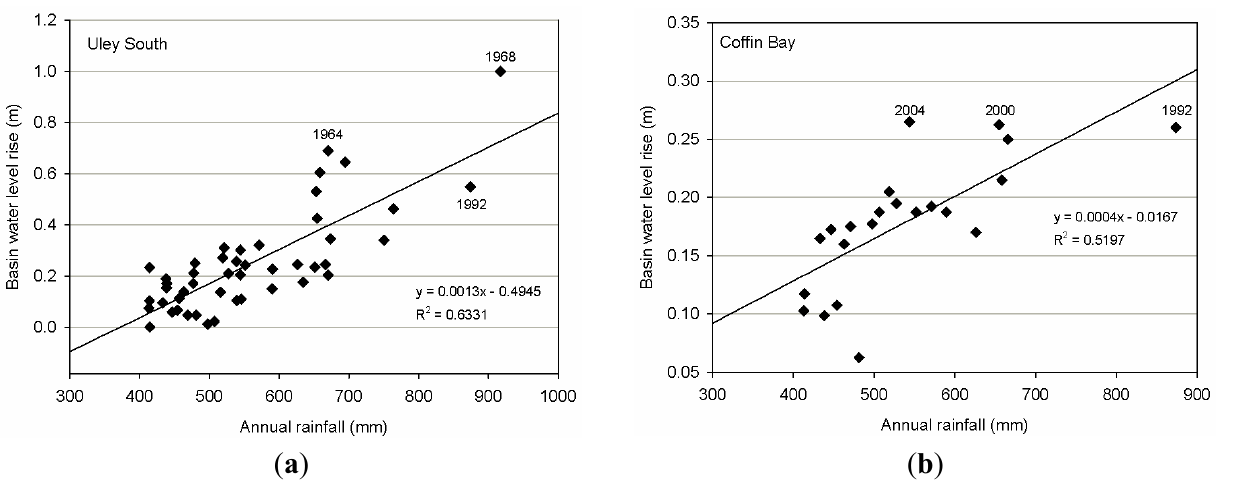
Figure 11. Basin water level response to annual rainfall in Uley South basin and Coffin Bay lens A. ( a ) Uley South; ( b ) Coffin